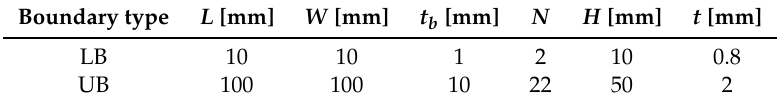
Table 4. Lower (LB) and upper (UB) boundary values for geometry parameters of the PFHS.